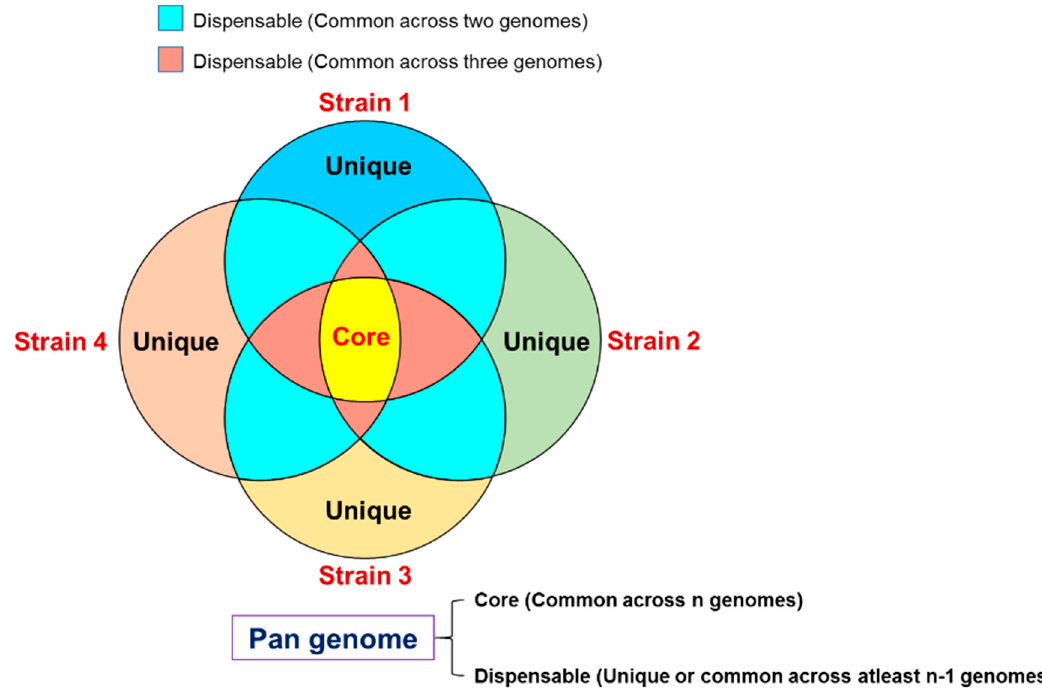
Figure 1. Organization of a pangenome composed of core and dispensable components of the ge- nome.